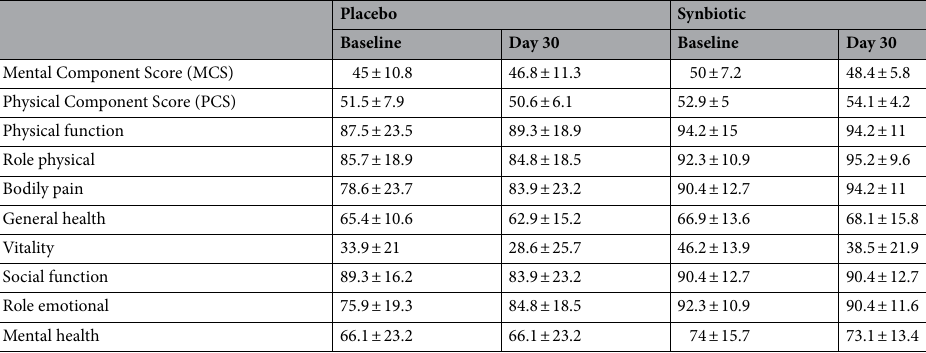
Table 2. Mental and physical wellbeing according to Short-Form 12-item (SF-12) questionnaire in middle- aged adults receiving placebo or synbiotic for 30 days. Values are means ± SD (placebo: n = 14, synbiotic: n = 13). Matched-pairs Wilcoxon signed-rank tests were performed to compare changes from baseline (within- group variations; p > 0.05). Between-groups variations were analyzed by Mann–Whitney U-tests (p >